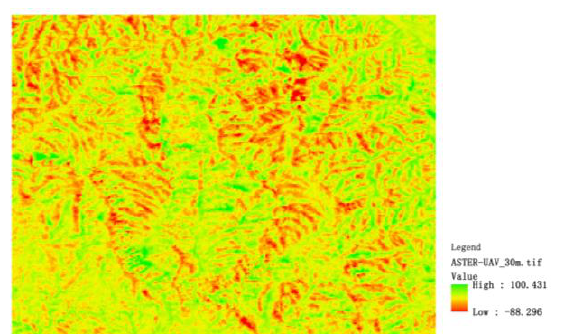
Figure 9. The spatial distribution of the errors derived from the ASTER DEM and the UAV DEM (30m resolution) The maximum and the minimum error are 100.43m and - 88.30m respectively. The histogram of the errors is shown in Figure 10. Statistical test shows that the errors come from